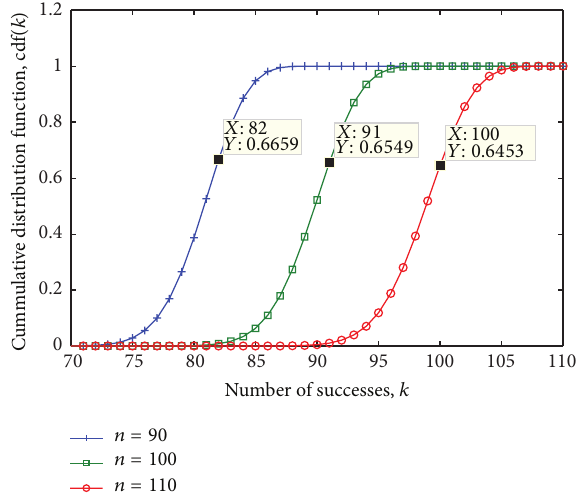
Figure 7: Probability of success for various trials with